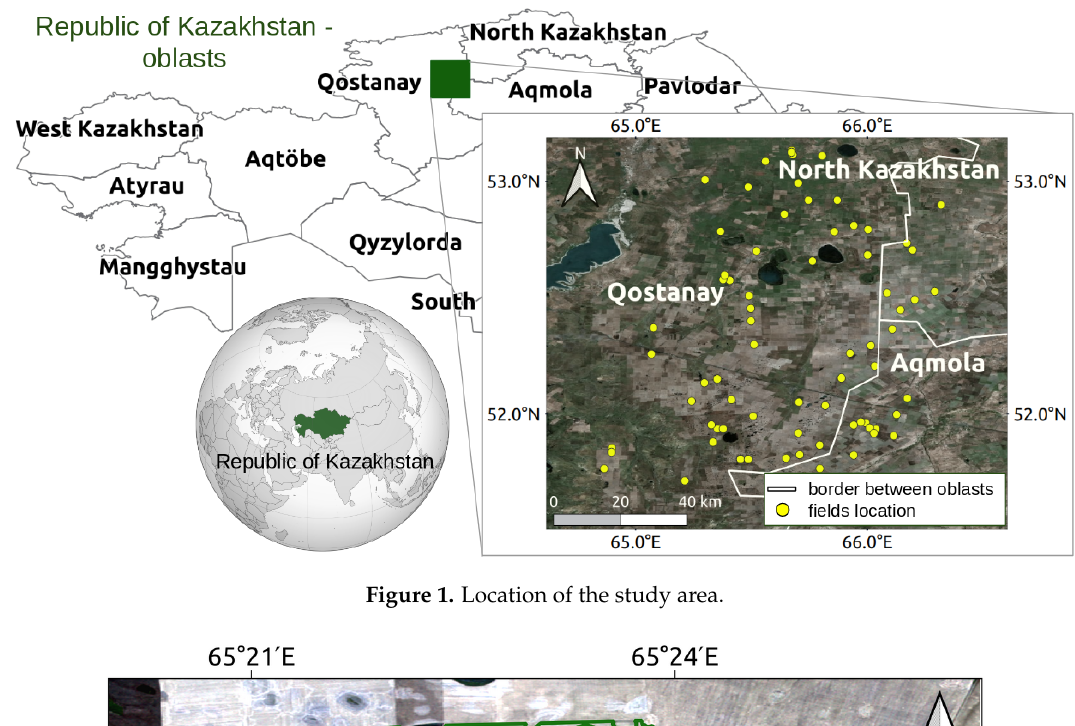
Figure 1. Location of the study area.